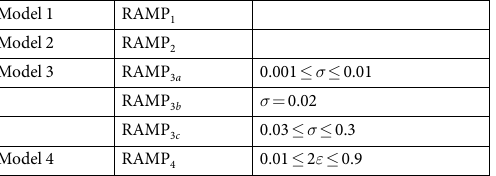
Table 6. The choice of RAMP parameters for models 1–4 in our computational